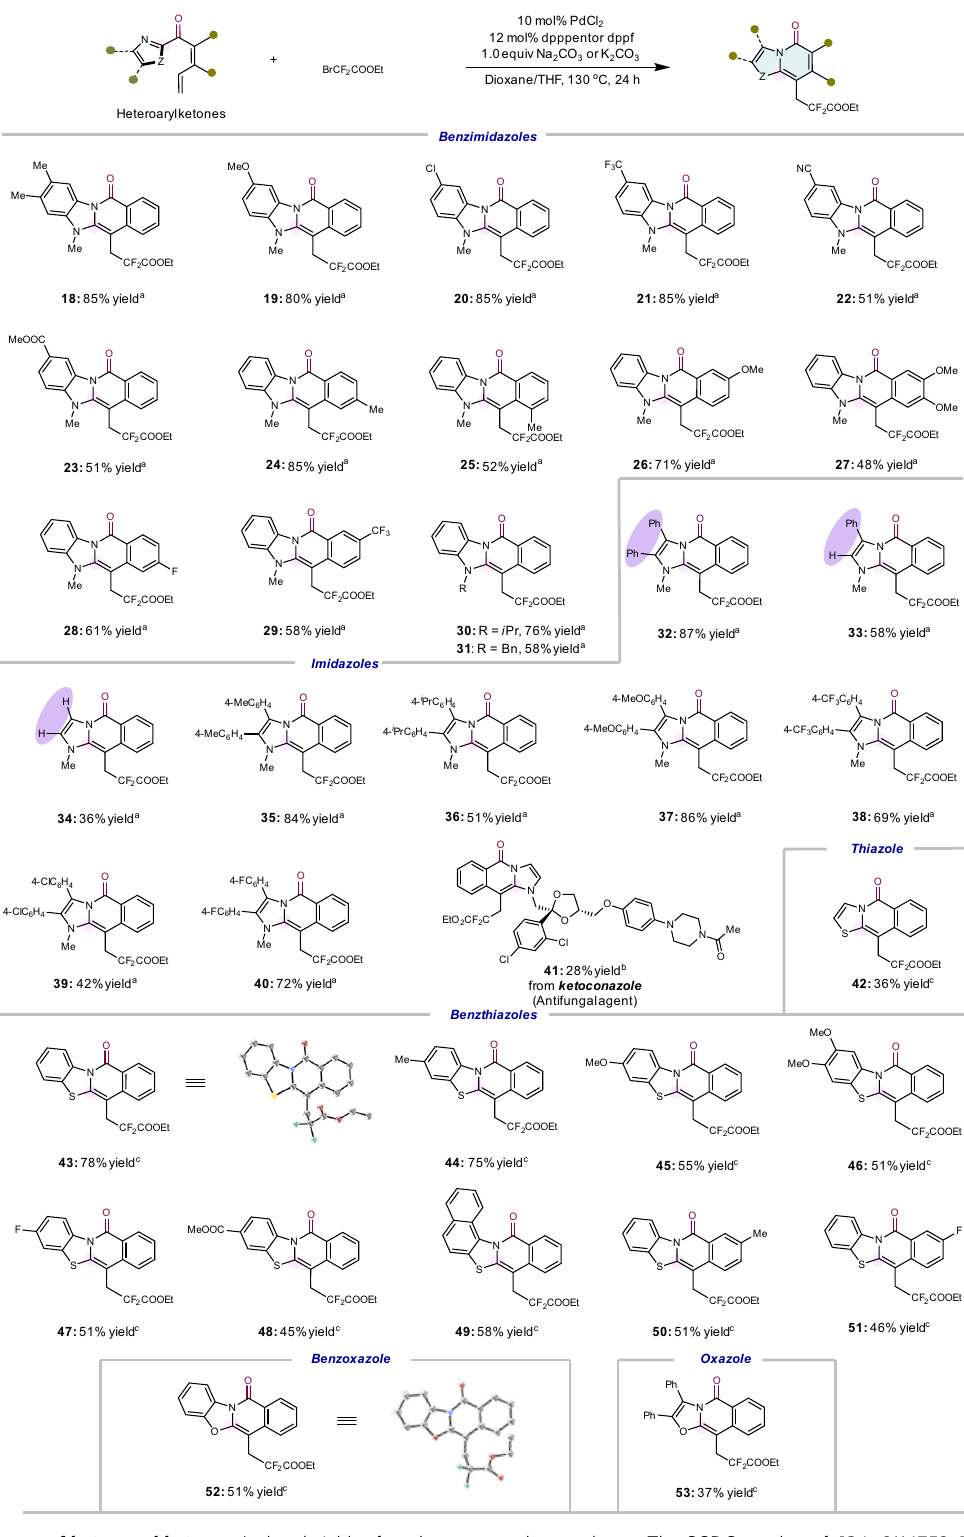
Fig. 3 Substrate scope of heteroaryl ketones. Isolated yields after chromatography are shown. The CCDC number of 43 is 2116753, 52 is 2116752. a